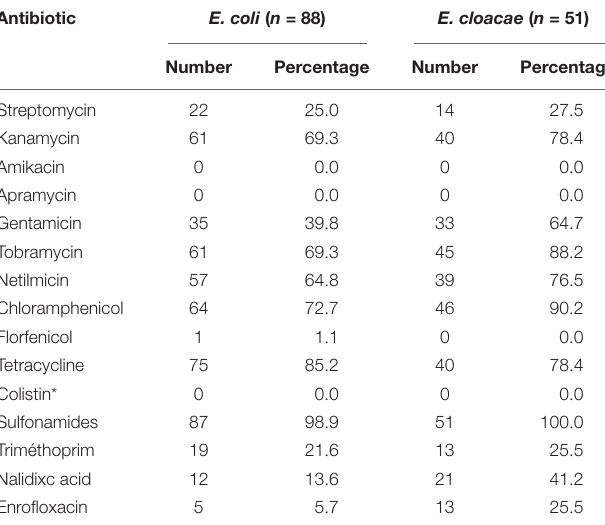
TABLE 1 | Phenotypic resistances associated to ESBL-producing E. coli and E. cloacae . Antibiotic